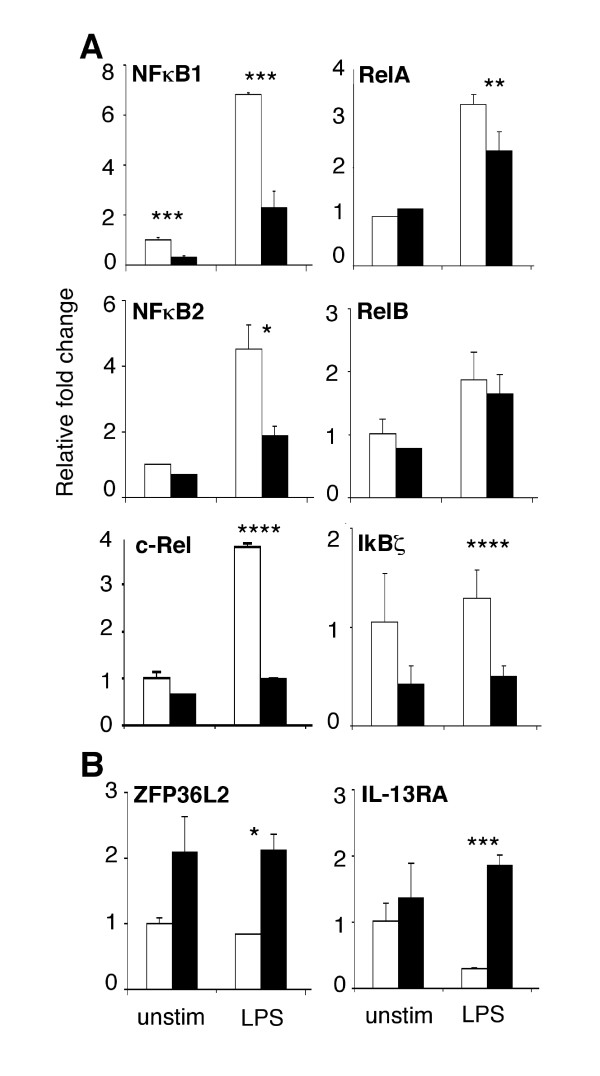
Differential regulation of elements that regulate gene transcription and translation in IRAK4-deficient monocytes. The relative expression (Y-axis) of (A) NFκB subunits NFκB1 (p105/50), NFκB2 (p100/52), RelA (p65), RelB & c-Rel, NFκB regulator IκBζ, and (B) translational suppressors IL-13RA & ZFP36L2 in IRAK4-deficient monocytes (black bars) and controls (white bars) was measured by real-time PCR following 4 hr incubation in the absence or presence of LPS (X-axis). Results show gene expression relative to unstimulated control monocytes and are representative of 3 independent experiments. Differences in expression were determined to be statistically significant by Student's two tailed T-test with a value of p < 0.15 (*), p < 0.1 (**), p < 0.05 (***) or p < 0.01 (****).